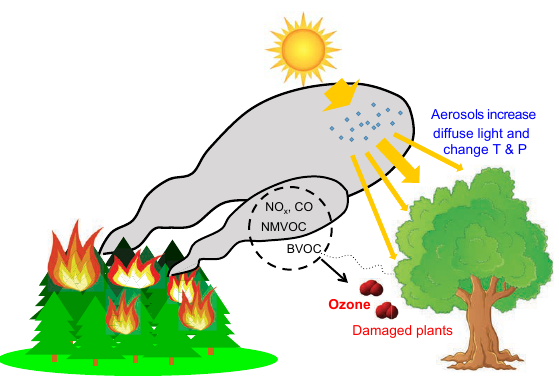
Figure 1. Illustration of atmospheric chemistry and physics as . Illustration of atmospheric chemistry and physics, and biospheric processes well as biospheric processes investigated in the study. Carbona- fire plumes increase diffuse light and ceous aerosols from fire plumes increase diffuse light and change temperature and precipitation, influencing vegetation photosynthesis. Ozone temperature (T) and precipitation (P), influencing vegetation pho- -emitted precursors (NOx, CO, and non-methane volatile tosynthesis. Ozone generated photochemically from fire-emitted (NMVOC)) and associated BVOC changes causes direct damage to plant precursors (NO x , CO, and non-methane volatile organic com- ynthesis. pounds, NMVOC) and associated biogenic volatile organic com- pound (BVOC) changes causes direct damage to plant photosyn-